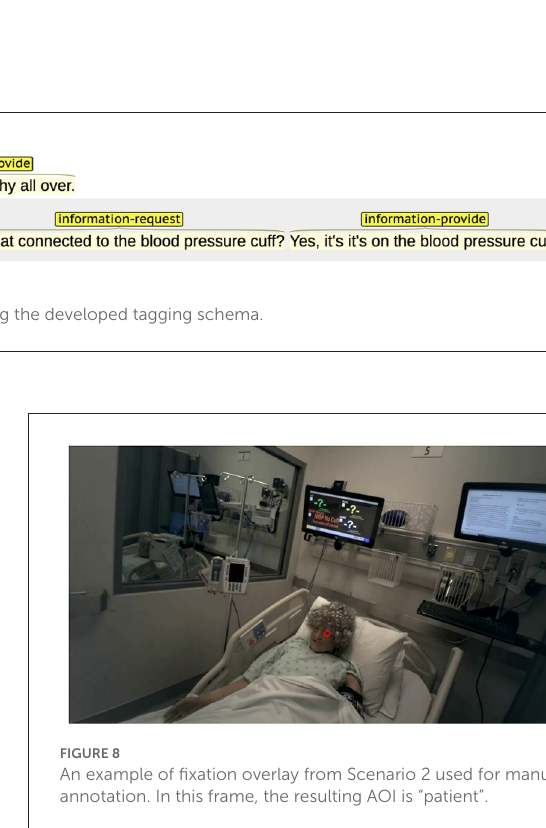
tagging is performed through visual inspection of the egocentric video with fixation data overlaid. In each case where the nurse fixates on one of the AOIs, the start and end time of the fixations are recorded. An example of the gaze overlaid on the video is shown in Figure 8, where the red circle marks the